Question: Is the quantity shown trending increasing or decreasing?
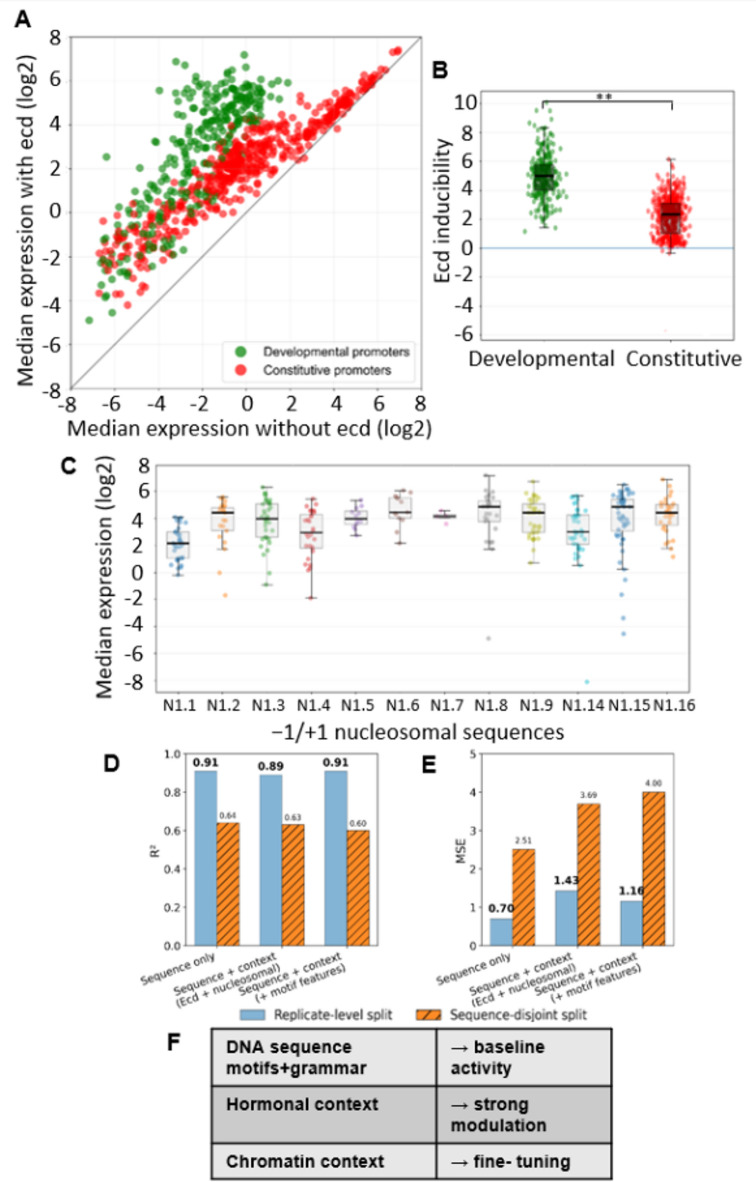
Answer: increasing